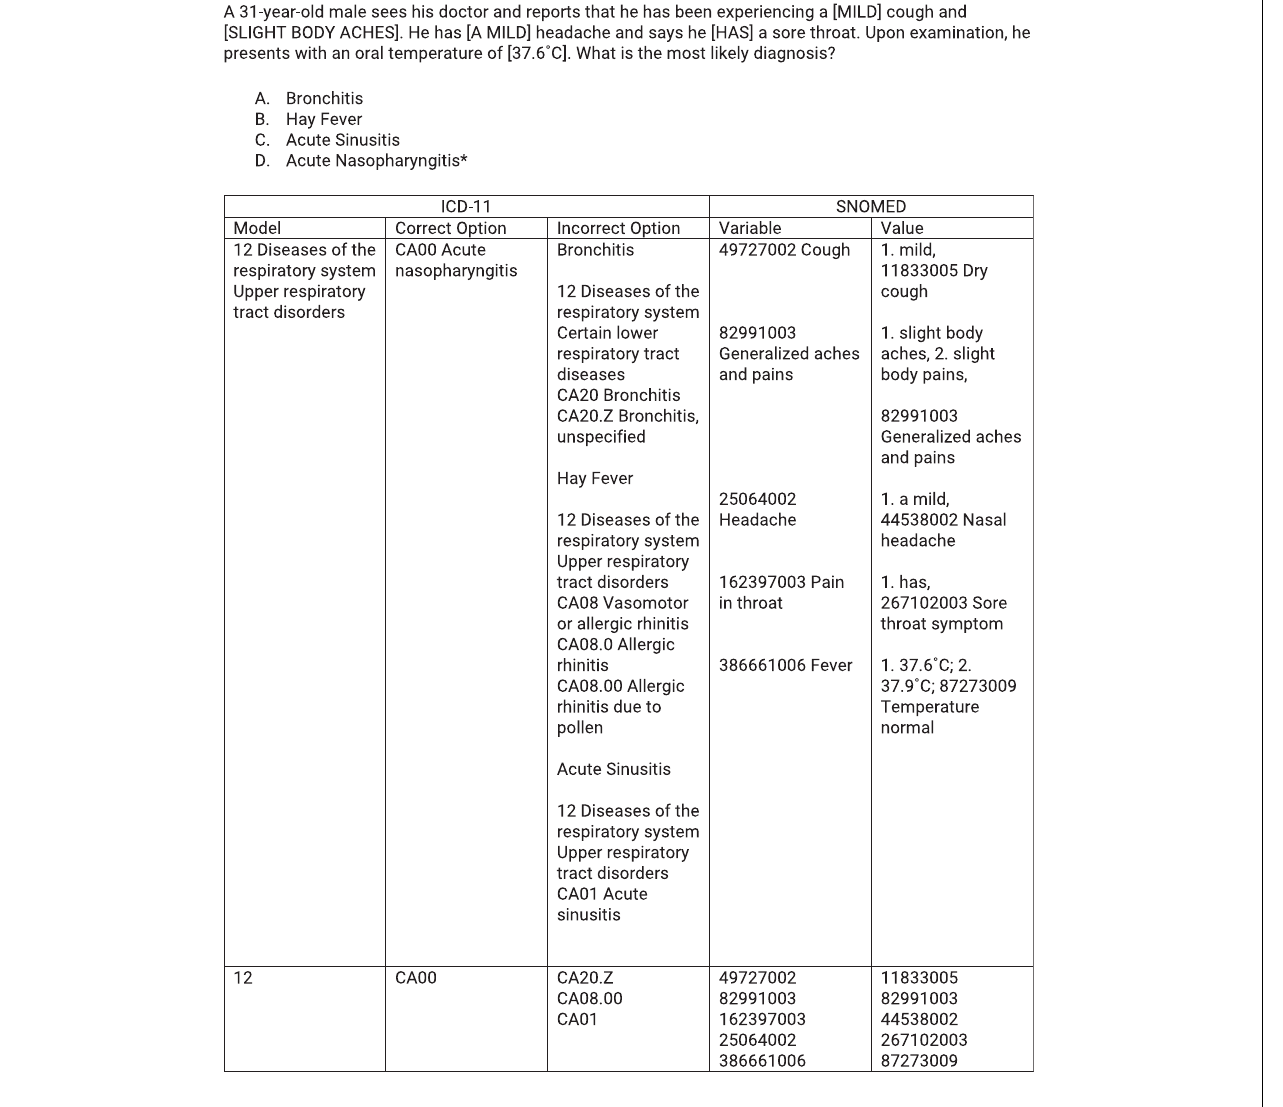
FIGURE 1 | ICD-11 and SNOMED content codes for one generated item with